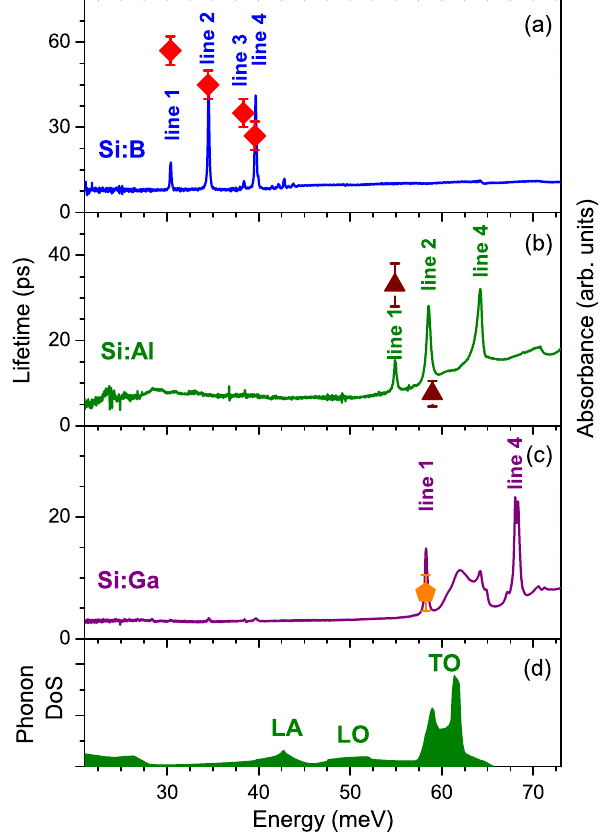
FIG. 7. Spectral dependence of acceptor population decay. (a) The absorption spectrum for B-doped Si at 5 K, measured by FTIR spectroscopy with 0.02 meV resolution (right axis). The decay time of the indicated transitions at low laser power, determined from pump-probe transients (such as those in Fig. 3) are shown by the solid symbols (left axis). (b) The corresponding results for Si:Al . (c) The corresponding results for Si:Ga . (d) The one-phonon density of states (DOS), including longitudinal-optical (LO), longitudinal-acoustic (LA), and transverse-optical (TO) phonon modes of silicon, which deter- mines the phonon-emission decay rate at low temperatures (taken from Ref. [27]).